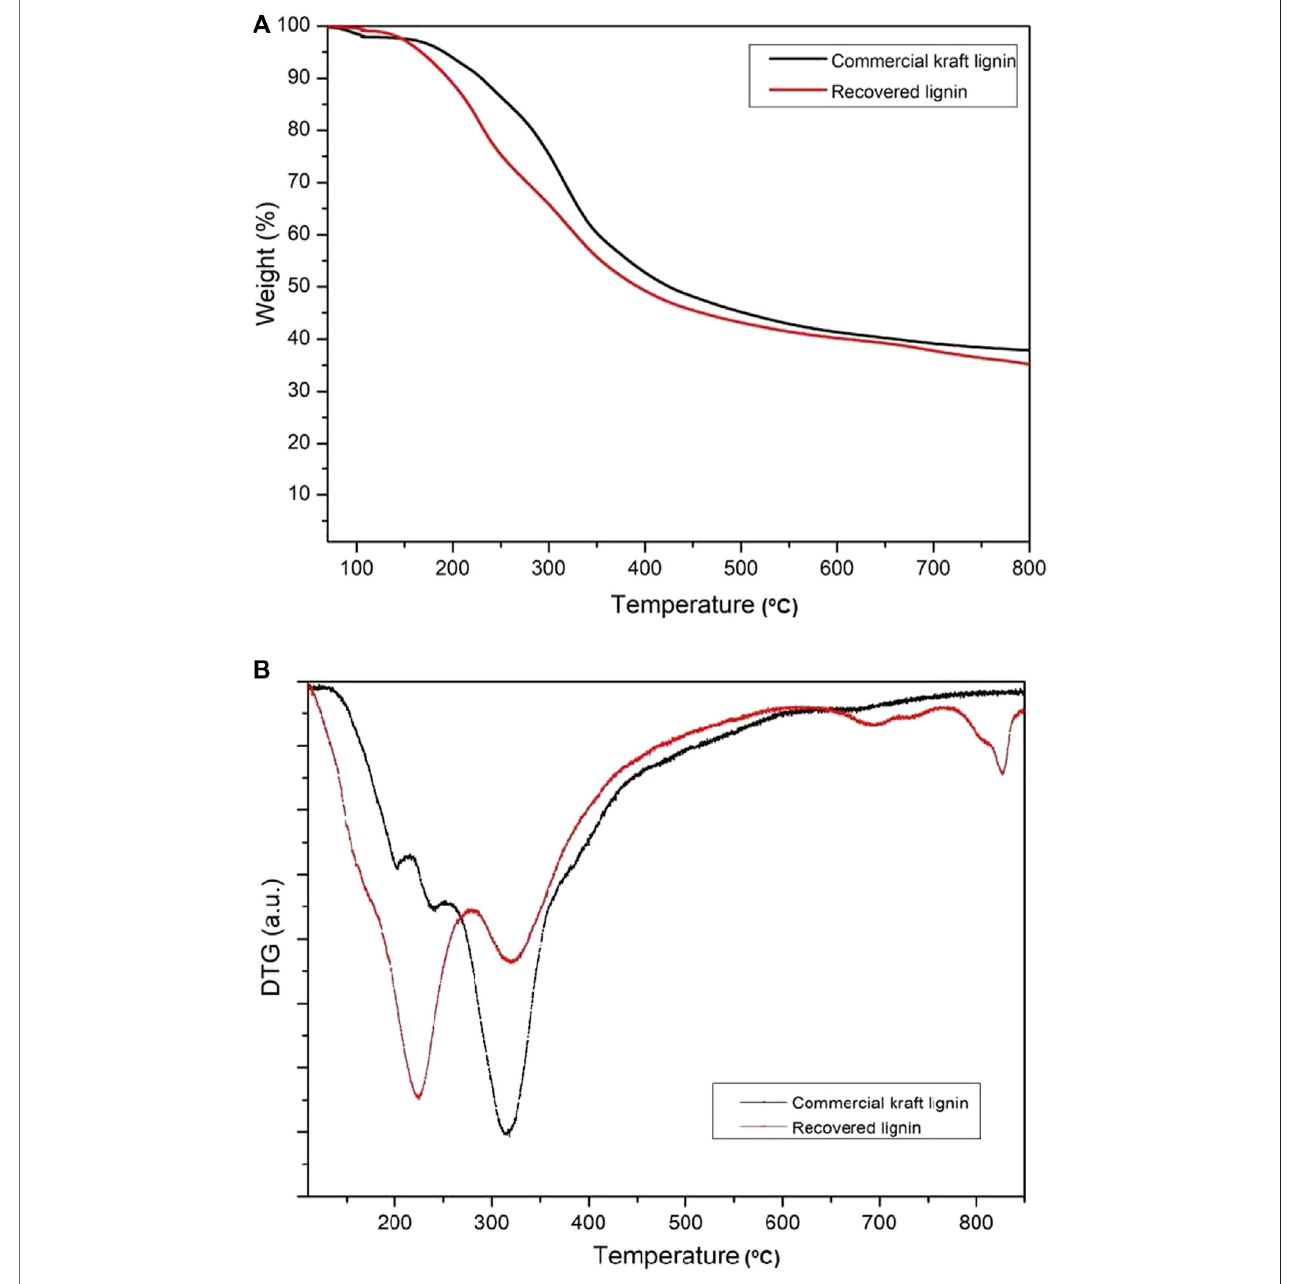
FIGURE 5 | (A) TG (weight loss) and (B) DTG (derivatives of weight loss) curves of commercial kraft lignin and recovered lignin after solvothermal